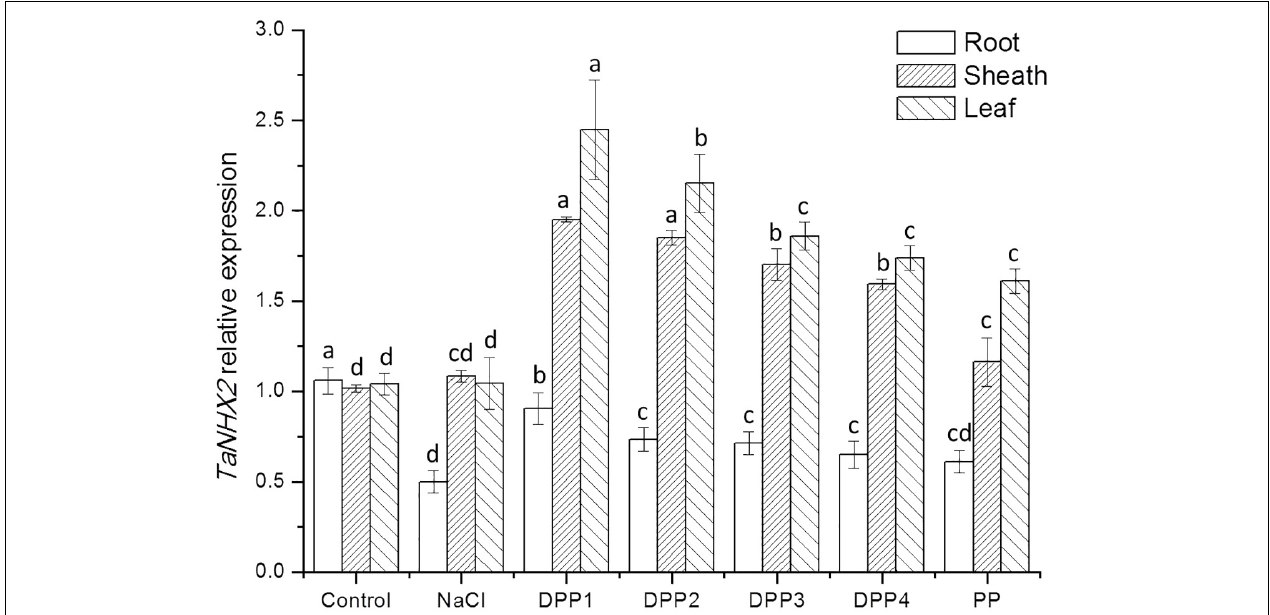
FIGURE 10 | Effect of four degraded (DPP1,2,3,4) and natural polysaccharides (PP) from P. yezoensis on TaNHX2 expression of root, sheath, and leaf in wheat seedlings. Values are the mean ± SD of three replicates. Different letters indicate significant differences at P < 0.05.